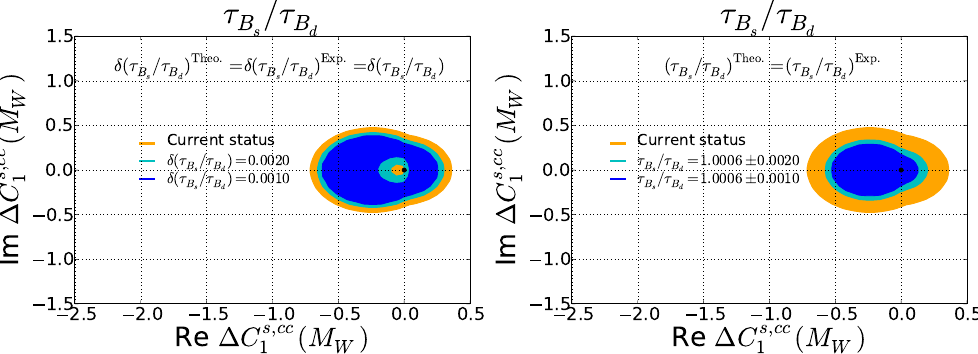
Figure 24 . Future scenarios concerning the behaviour of (cid:28) B experimental value of the lifetime ratio is assumed to remain unchanged in the future whereas the uncertainties will be reduced. In the right panel, the theoretical and experimental values for the lifetime ratio are supposed to become equal. The black dot corresponds to the SM